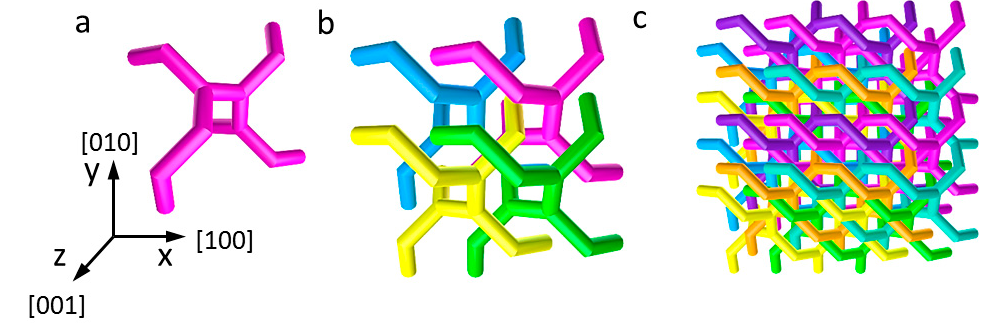
Figure 1. Formation of an 8-srs network. ( a ) Typical component of a right handed 1-srs network. ( b ) Three copies of the 1-srs network are translated by half a unit cell along [100], [010], and [110] crystallographic directions to form a 4-srs network. ( c ) A single copy of the 4-srs network is translated by 1/4 of a unit cell along the [111] crystallographic direction to obtain an 8-srs network.